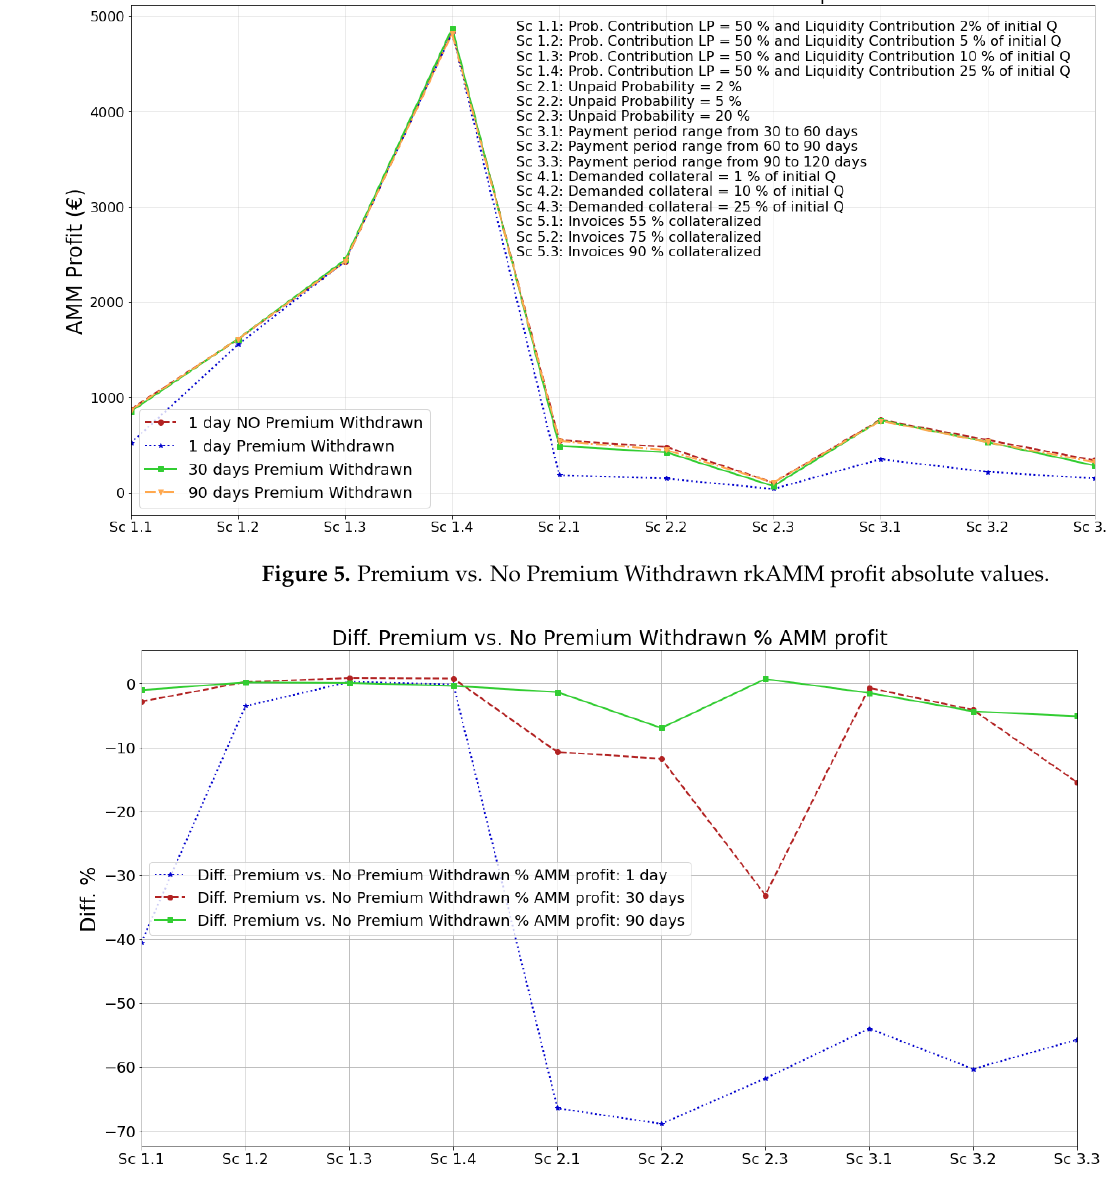
Figure 6. Premium vs. No Premium Withdrawn rkAMM profit